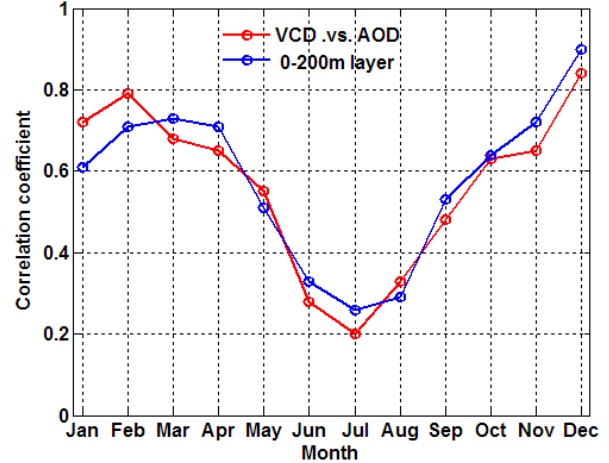
Figure 17. Seasonal variation of the correlation coefficient between SO 2 and aerosols over the March 2010–February 2013 period. The red curve corresponds to VCD versus AOD and the blue curve to SO 2 concentration versus aerosol extinction coefficient in the 0– 200m